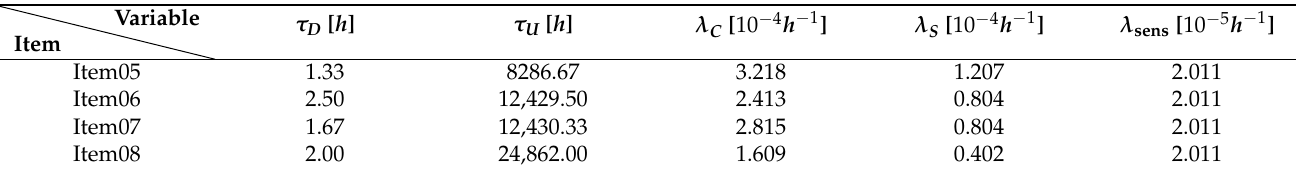
Table 3. Reliability parameter estimation from maintenance record data.